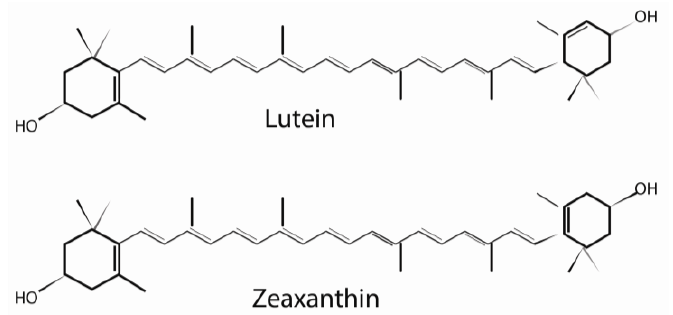
Figure 2. Chemical structures of lutein and zeaxanthin.